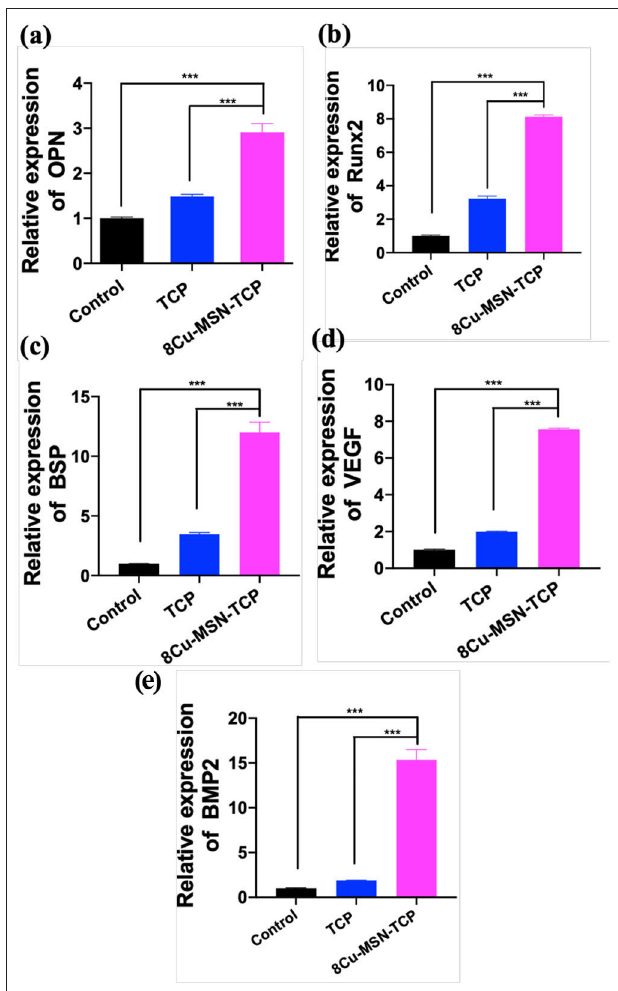
FIGURE 7 | The osteogenic differentiation of rabbit bone marrow-derived mesenchymal stem cells was assessed by RT-qPCR. The gene expression of OPN (a) , Runx2 (b) , BSP (c) , VEGF (d) , BMP 2 (e) in the blank group, β -TCP, and 8Cu-MSN-TCP scaffolds ( n = 3). 8Cu-MSN-TCP scaffolds can recognize the promotion of